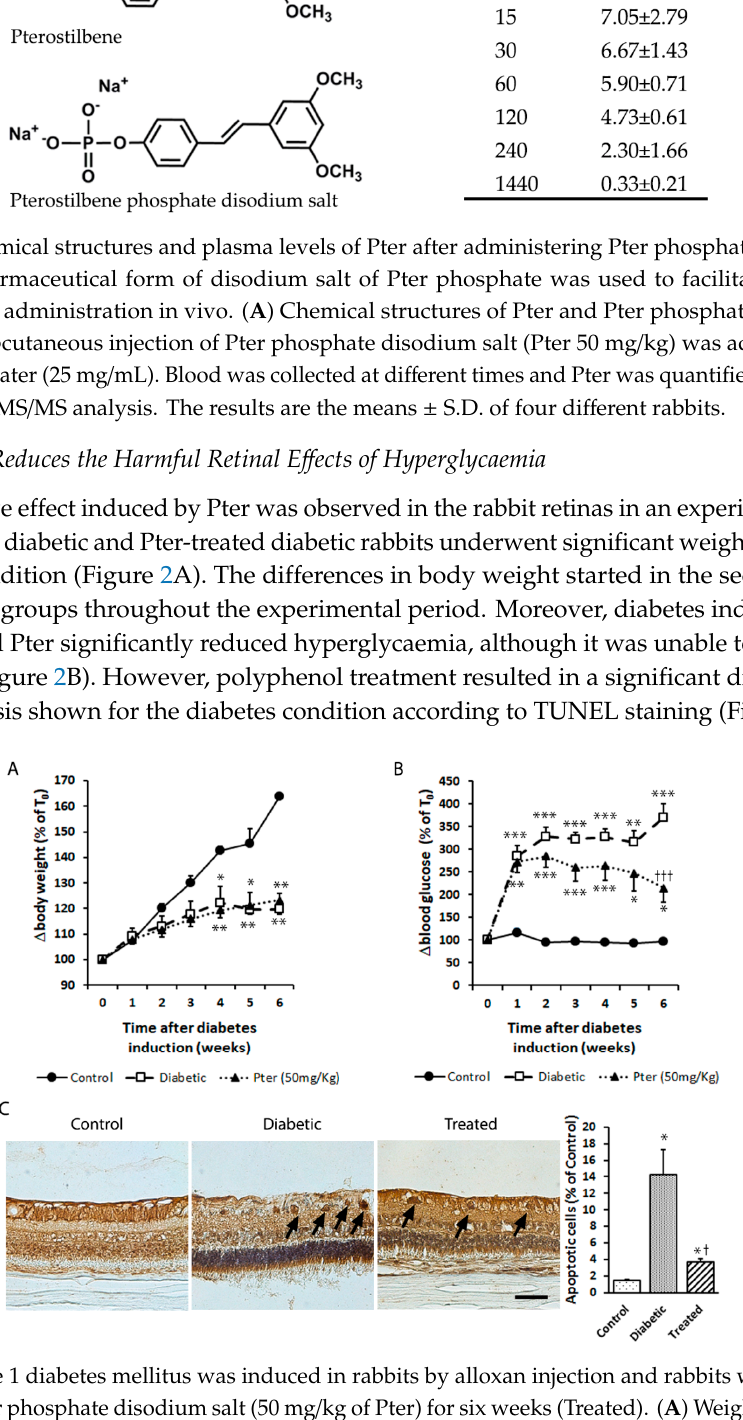
Figure 2. Type 1 diabetes mellitus was induced in rabbits by alloxan injection and rabbits were treated daily with Pter phosphate disodium salt (50 mg/kg of Pter) for six weeks (Treated). ( A ) Weight (BW) and ( B ) blood glucose (BG) levels were evaluated weekly. ( C ) Retinal apoptotic cell death was examined and quantified by TUNEL staining (black bar = 50 μ m) six weeks after diabetes induction. Black arrows mark apoptotic cells. Data are presented as mean ± S.E.M. (at least n = 5 in each group). An ANOVA, followed by Tukey’s post hoc test, was used to assess significant di ff erences between experimental conditions. * p < 0.05; ** p < 0.01; *** p < 0.001 versus the control group. † p < 0.05; ††† p < 0.001 versus the diabetic